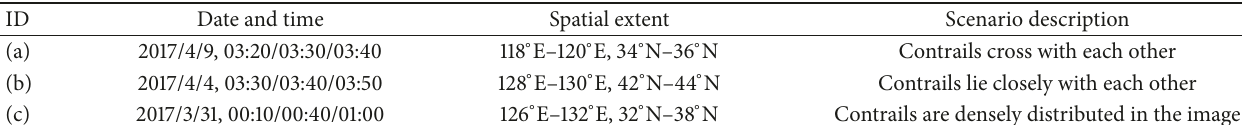
Table 2: Different scenarios of contrails distribution.